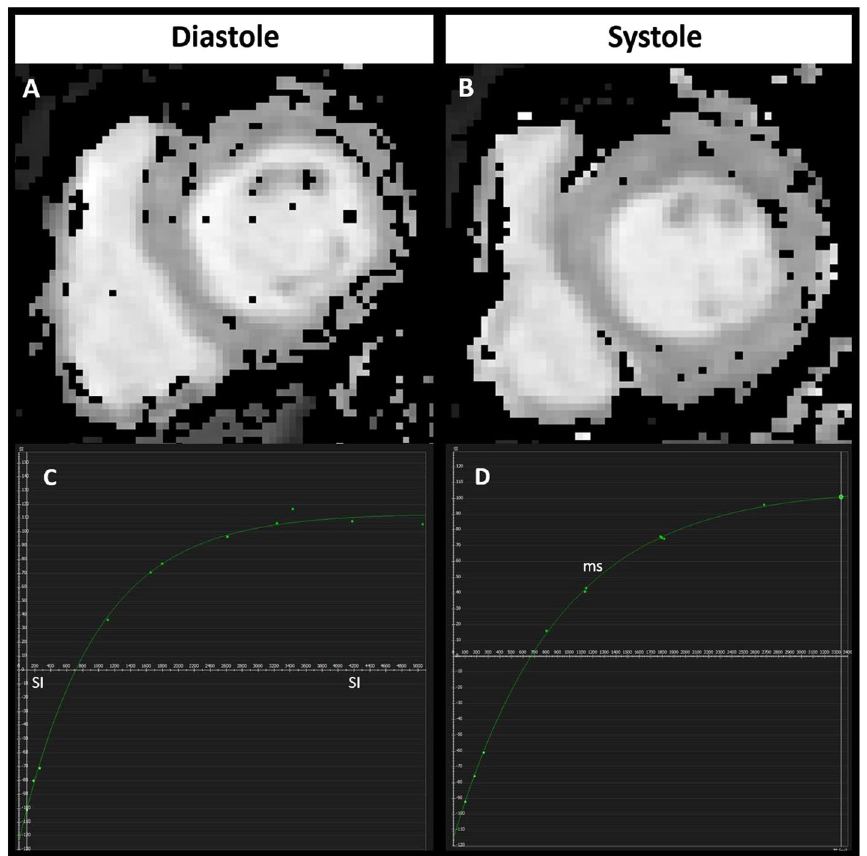
Figure 2. Examples showing how goodness-of-fit R 2 values were generated in diastole ( A + C ) and systole ( B + D ) by in-house software. Graphs ( C + D ) demonstrate the greater difference in measured T1 values to the fitted curve in diastole ( C ) compared to systole ( D ).